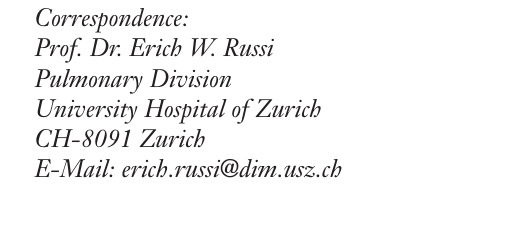
The transbronchial stent is placed over a guide wire and positioned in a newly created passage be- tween a subsegmen- tal bronchus and emphysematous lung tissue under flexible bronchoscopic